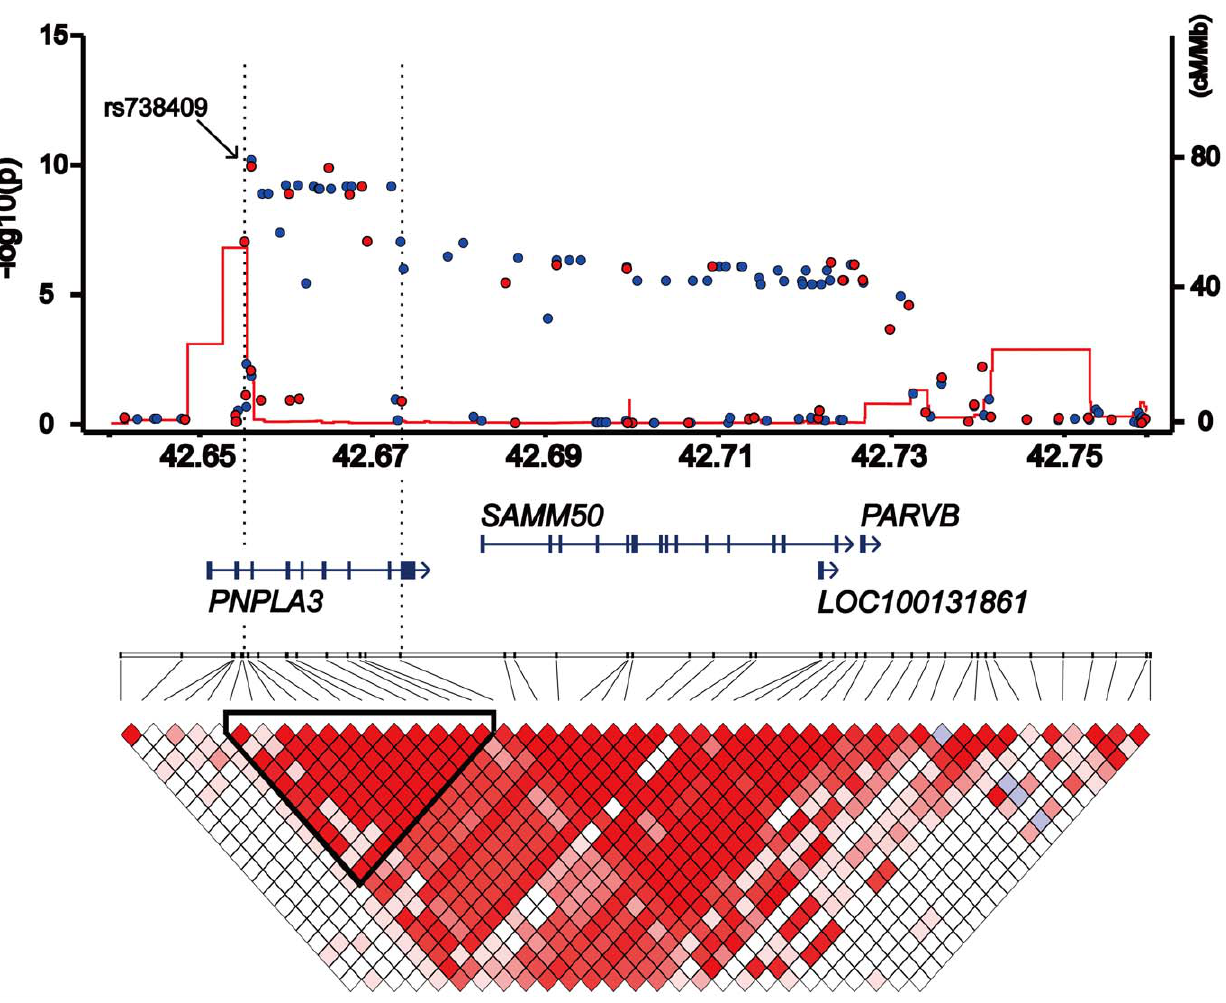
Figure 2. A schematic organization of the human PNPLA3 locus at 22q13.31 with the genome scan results. P -values calculated by the exact trend test were plotted in –log 10 scale. Red and blue dots indicate the p -values of genotyped and imputed SNPs, respectively. Local recombination rate obtained from HAPMAP release 22 is indicated by a red line plotted in cm/Mb scale. The structure and orientation of four genes in the region are shown below the plots with their transcriptional orientations according to NCBI Reference Sequence Build 36.3. LD blocks were generated according to pairwise LD estimates of the SNPs located within the region using the genome scan results. The LD block showing the strongest association is highlighted with the triangle, and the corresponding chromosomal region is represented by the dotted lines.